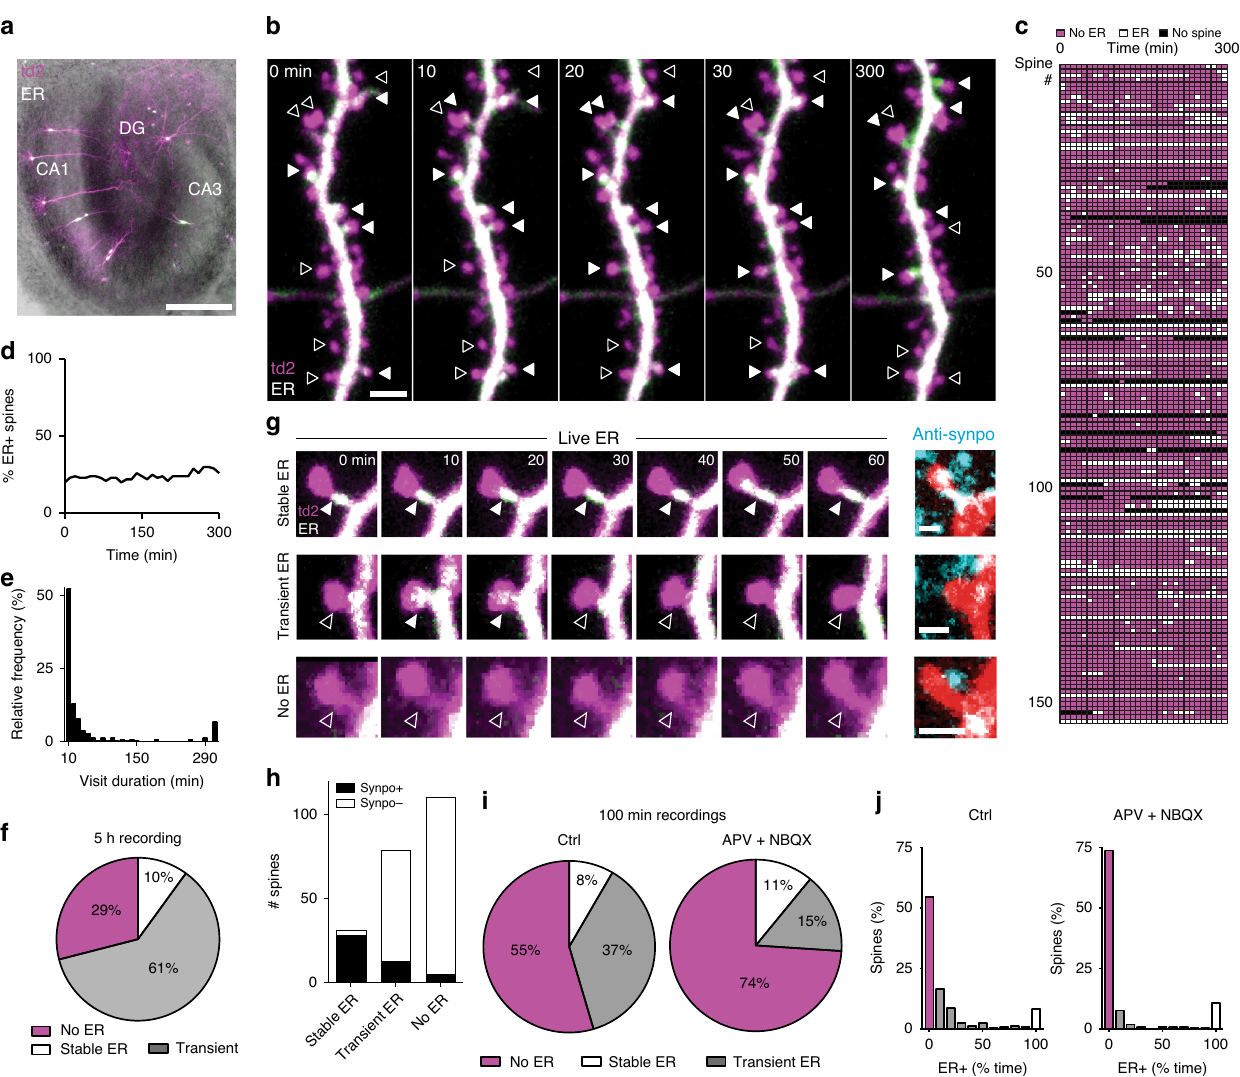
Fig. 1 ER dynamics is regulated by synaptic activity. a Organotypic hippocampal slice transfected using a Helios gene gun. Overlay of bright fi eld and fl uorescence images shows expression of tdimer2 (magenta) and ER-EGFP (green fl uorescence, white in overlay) in a few CA1 neurons. Scale bar: 500 μ m. Experiment was reproduced in ten slices. b Two-photon maximum intensity projections of a dendritic branch from a hippocampal CA1 pyramidal neuron transfected with tdimer2 (magenta) and ER-EGFP (green, white when over magenta) followed at 10 min intervals up to 5 h. Filled and empty arrowheads denote presence and absence of ER in a few representative spines, respectively. Scale bar: 2 μ m. Horizontal structure is an axon. Experiment was reproduced on three slices with similar results. c Score sheet of dendritic spines monitored over 5 h ( n = 153 spines, 2 neurons, 2 slices). Magenta: spine without ER; white: spine with ER; black: spine head not visible/not analyzed. d Percentage of spines from c containing ER over time. e Histogram of ER visit duration over a 5 h period (from c ). f Percentage of spines with stable ER, receiving at least one visit (transient ER) or no visit (no ER) within 5 h of observation (from c ). g Three examples (two-photon time series, maximum intensity projections) of spines with stable (top), transient (middle), or no ER (bottom), followed by correlative confocal images (maximum intensity projections) of the same spines (native tdimer2 fl uorescence, red) after fi xation of the tissue and immunostaining against synaptopodin (cyan). Scale bars: 1 µ m. Note synaptopodin clusters inside (white) as well as outside (cyan) the transfected neuron (red), as the antibody labels synaptopodin in the entire neuropil. Experiment was reproduced on two slices. h Synaptopodin clusters were detected in 90% of stable ER + spines, in 16% of transient ER spines, and in 4% of spines with no ER visit ( n = 220 correlatively imaged spines, 2 cells, 2 slices). i Over a period of 100 min, 45% of spines were visited by ER at least once. Blocking excitatory transmission (APV + NBQX) reduced the fraction of transiently visited spines from 37% ( n = 262 spines, 3 neurons, 3 slices) to 15% ( n = 192 spines, 2 neurons, 2 slices). j Residence time of ER in spines, under control conditions ( n = 262 spines, 3 neurons, 3 slices) and with blocked excitatory transmission ( n = 192 spines, 2 neurons, 2 slices) ( p = 0.0005, two-sided Mann – Whitney test). Source data are provided as a Source Data fi